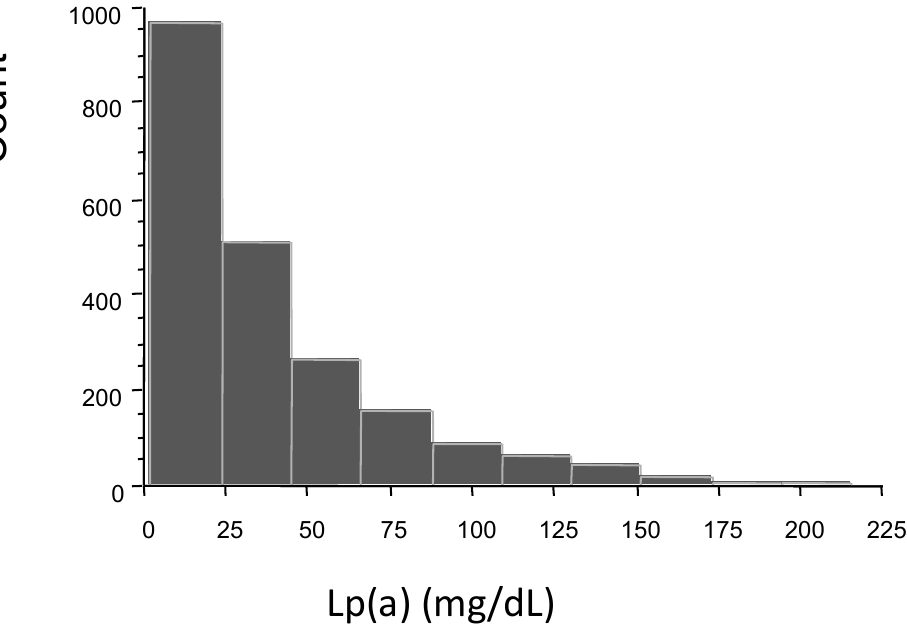
The distribution of Lp(a) in the cohort of patients was skewed to the right (Figure 1). The median level of lipoprotein was 27 mg/dL (29 and 26 mg/dL in female and male patients, respectively).